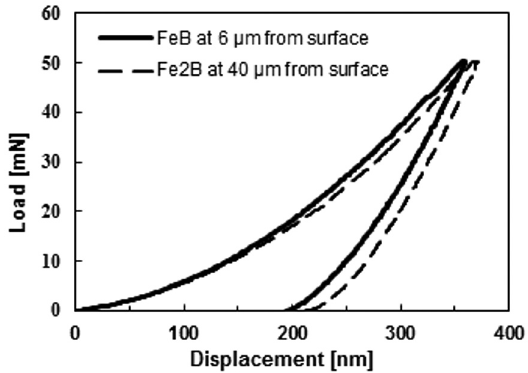
Figure 1. Load-displacement curves by depth sensing indentation using a load of 50 mN in FeB and Fe2B phases formed on AISI 304 steel at 1223 K for 10